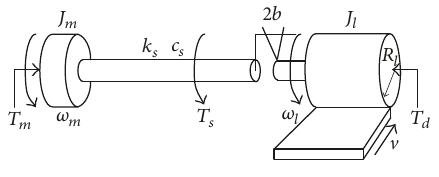
Figure 1: Mechanical model.